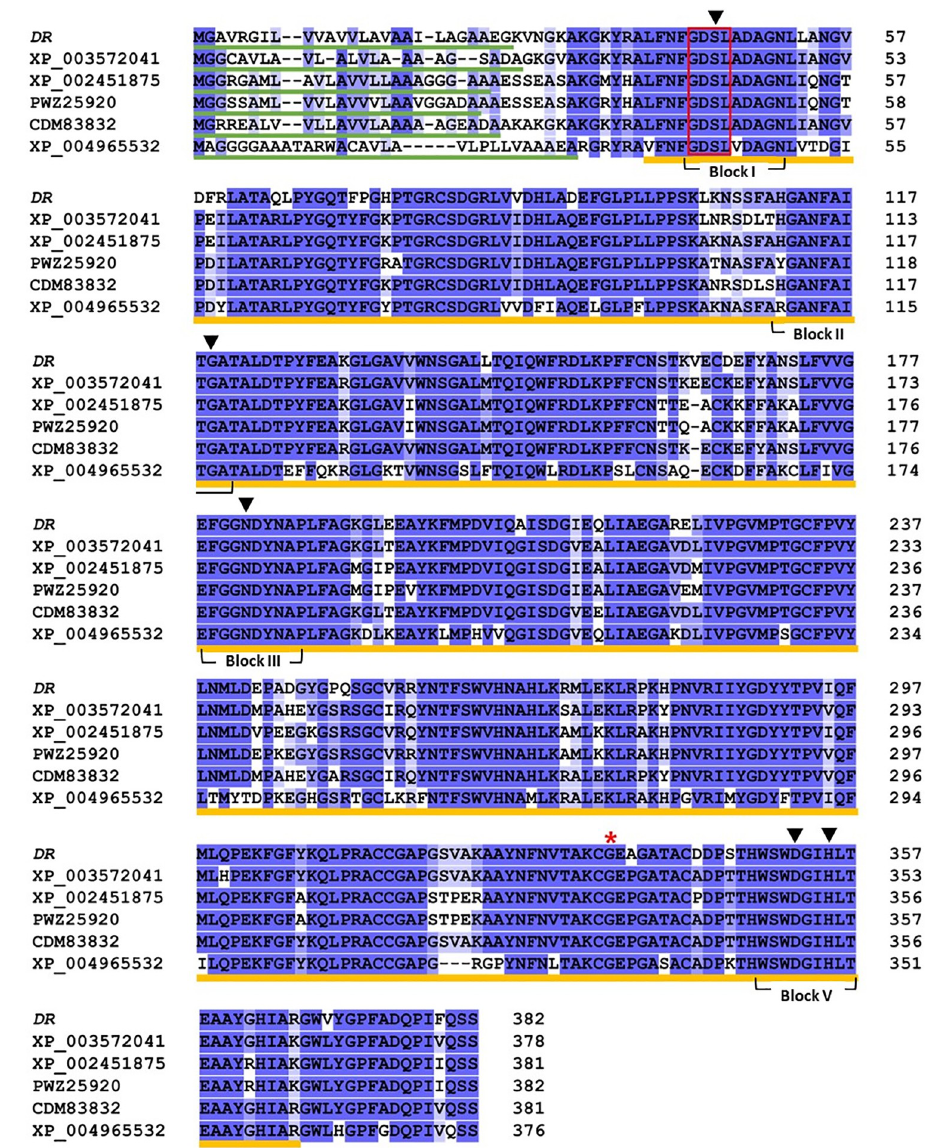
Fig 9. Multiple sequences alignment of the DR protein in various crops. The backgournd color (dark blue and light blue) boxes represent identical or similar amino acids. Block I to V indicate the conserved domains. N-terminal signal peptides and SGNH hydrolase domains are underlined with green and yellow line. GDSL motif is surrounded by red box. Red asterisks indicate amino acid residue which is changed by missense mutation in dr gene. The black arrowheads mark indicate the catalytic residues. XP_003572041; Brachypodium distachyon , XP_002451875; Sorghum bicolor , PWZ25920; Zea mays , CDM83832; Triticum aestivum , XP_004965532; Setaria italica